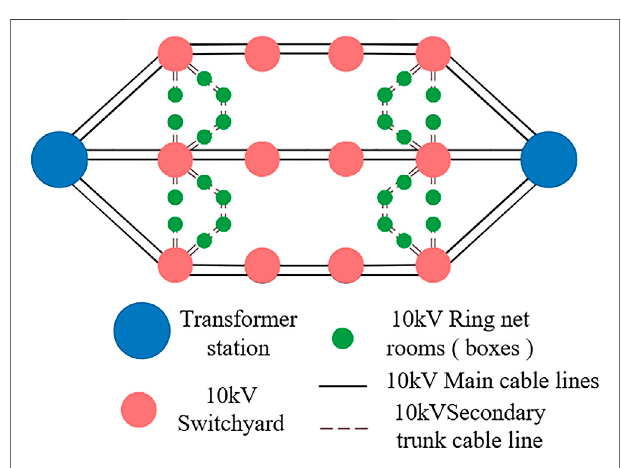
FIGURE 5 | Shanghai diamond wiring